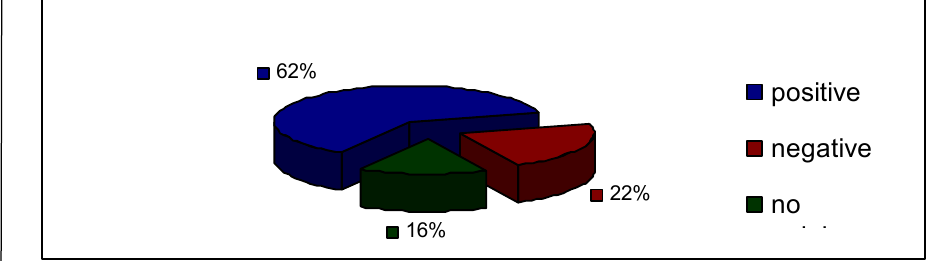
Figure 3 – Assessment of trust in the command